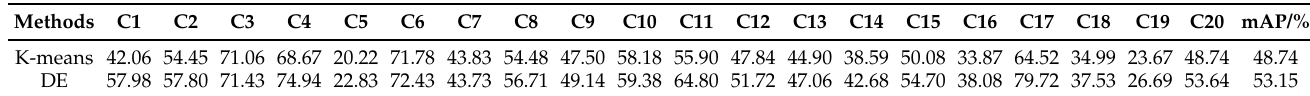
Figure 10. Comparison of the anchor configuration results in the DIOR dataset. Table 9. Mode detailed mAP (%) results of ablation experiments on the DIOR dataset.